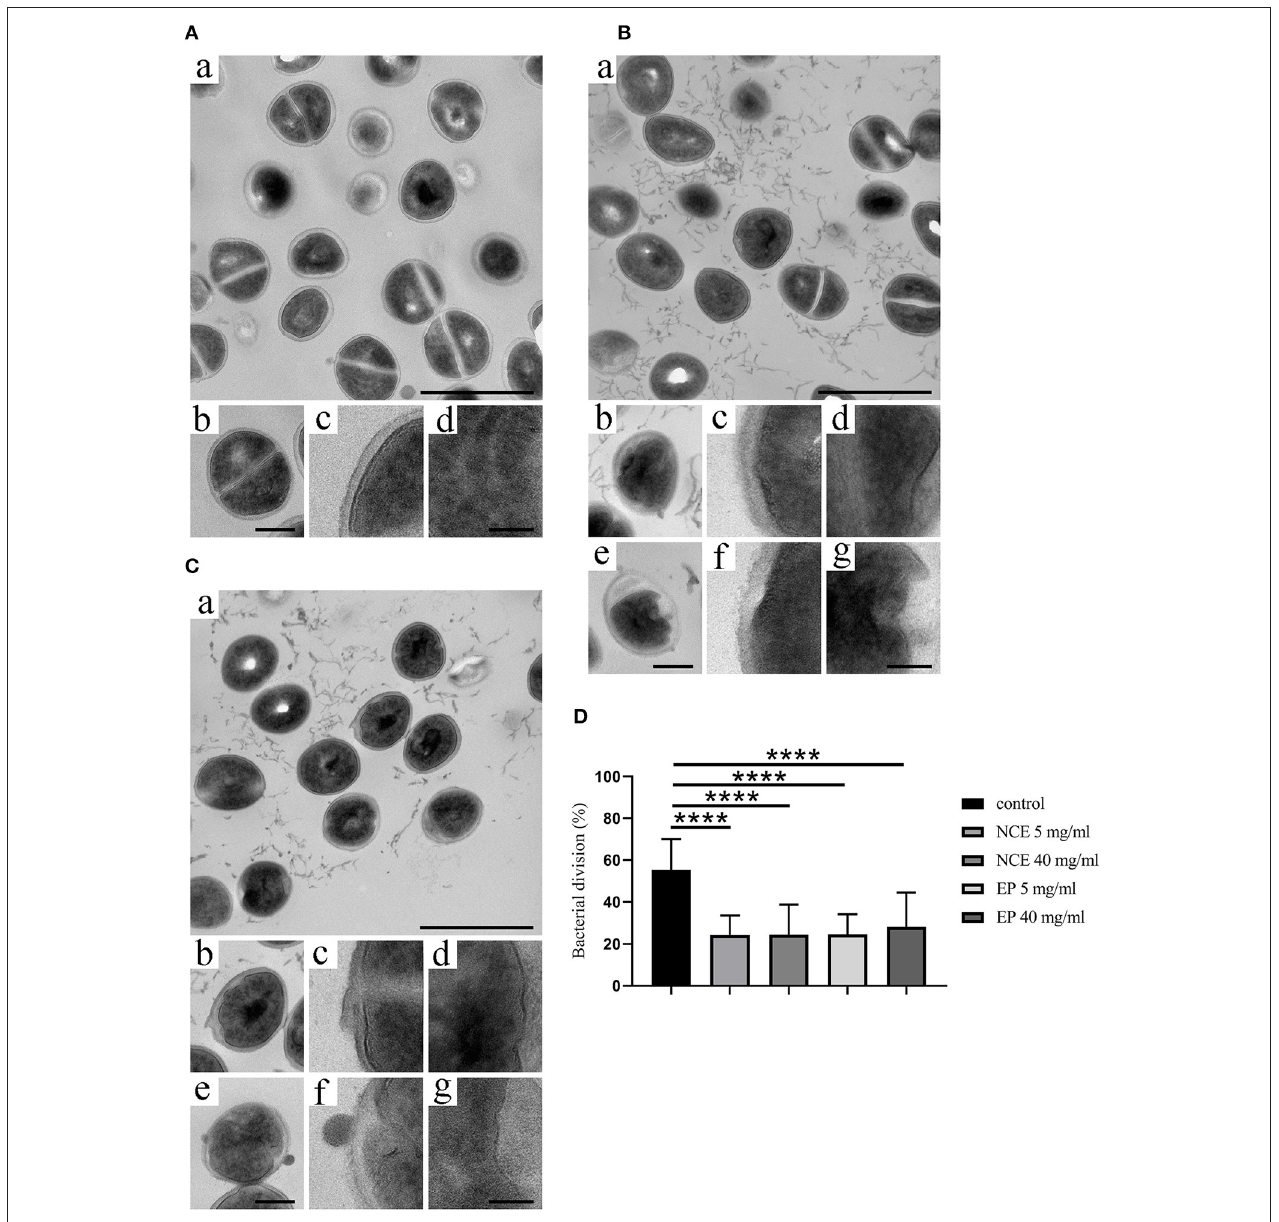
FIGURE 3 | Natural crude extract (NCE) and ethanol precipitate (EP) inhibited cell division of S. aureus. S. aureus Newman was incubated for 8h in the presence of (A) MHB medium as negative control, (B) NCE, and (C) EP. Samples were embedded in Epon, thin sectioned, and analyzed with transmission electron microscopic analysis. (A) Incubation with MHB showed no surface changes. (a) Overview; the scale bar represents 1 µ m. (b) A representative bacterium at higher magnification, exhibiting an undisturbed architecture with homogenous cytoplasm and a central plane of cell division. The scale bar represents 250nm. (c,d) Higher magnification of cellular aspects exhibiting the homogenous bacterial cell wall (c) and the homogenous cytoplasm (d). The scale bar represents 100nm. (B,C) S. aureus Newman were analyzed with electron microscopy after incubation with 5mg/ml and 40mg/ml NCE (B) or 5mg/ml and 40mg/ml EP (C) . Incubation with 5mg/ml NCE or EP (a–d), or 40mg/ml NCE or EP (e,f), respectively. (a) Overview. NCE and EP generate an antibacterial effect with moderate morphological changes in bacterial architecture, occasional cytoplasmic blebbing, and less frequent central planes of cell division. The scale bar represents 1 µ m. (b,e) Representative bacteria at higher magnification are shown, exhibiting a moderately disturbed architecture with less electron dense cytoplasmic regions and the absence of a central plane of division. The scale bar represents 250nm. (c,d,f,g) Higher magnification of cellular aspects exhibiting the bacterial cell wall, which appears thicker and irregular as compared to the control (c,f). The cytoplasm appears heterogeneous and contains areas of less electron density (d,g). The scale bar represents 100nm. (D) Percentage of the bacterial division was calculated. The percentage of dividing cells is lower in the NCE- and EP-treated group compared to growth control. Statistical analysis was done by one-way ANOVA followed by Dunnett’s test compared to media control. Per treatment, 30 bacteria were counted in one viewing field and a total of 50 viewing fields were analyzed. All data are shown as means ± SD. **** P ≤ 0.0001 was considered significant.